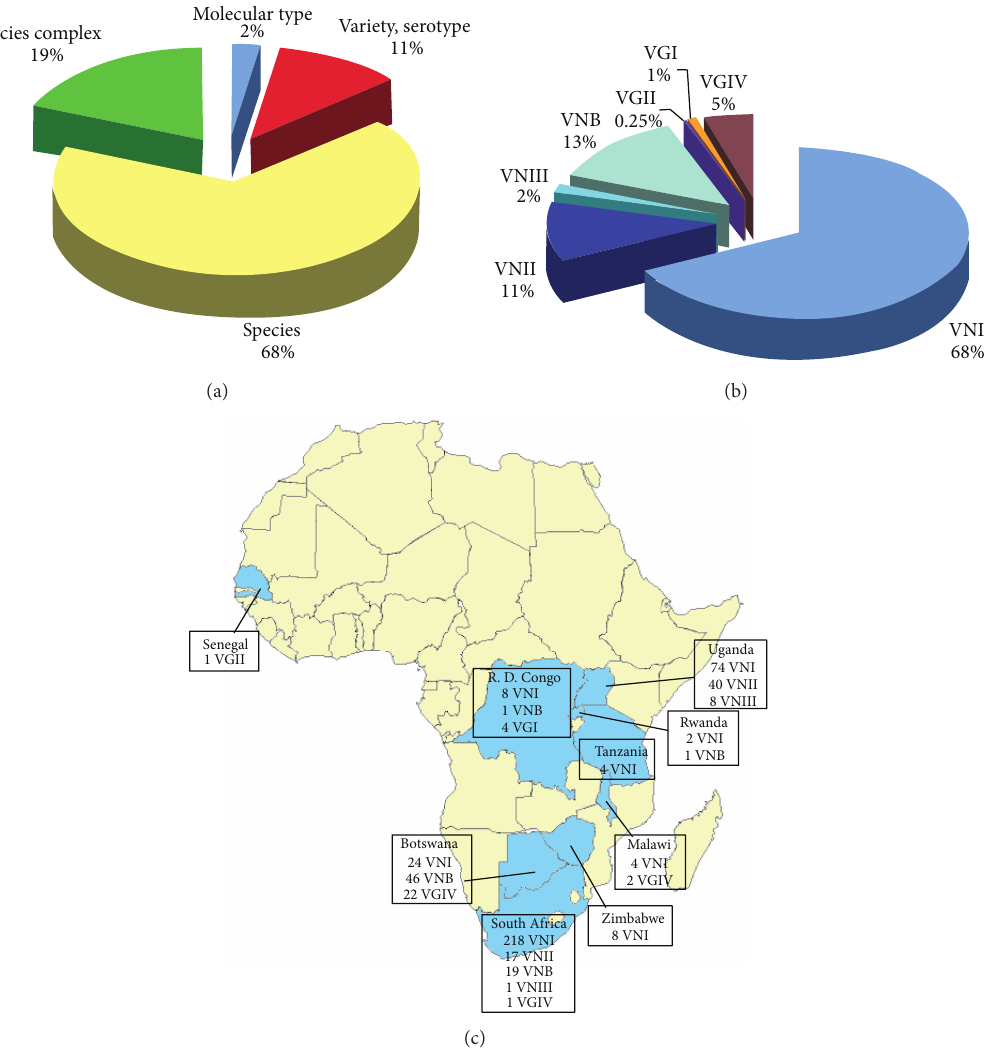
F 6: Percentage of Cryptococcus neoformans and Cryptococcus gattii isolates ( variety/serotype, or molecular type level (a). Prevalence of the di�erent VN and VG molecular types among the isolates identi�ed at molecular type level ( 𝑛𝑛 𝑛